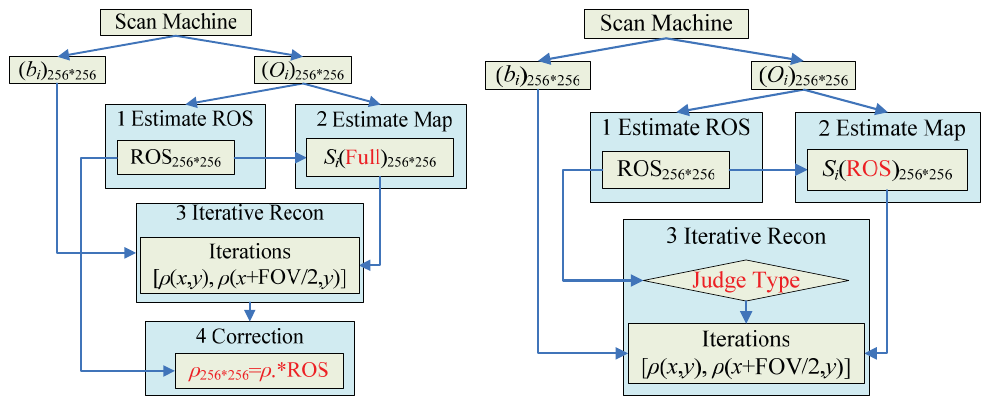
256 × (cid:2)(cid:3)(cid:4) (cid:5)(cid:6) = ±2.56 in their gray intensity values. Figure 5. Flowchart of ( a ) ROS-based correction; ( b ) ROS-based reconstruction (the differences are labeled with red color), please see the paragraph below for the details.